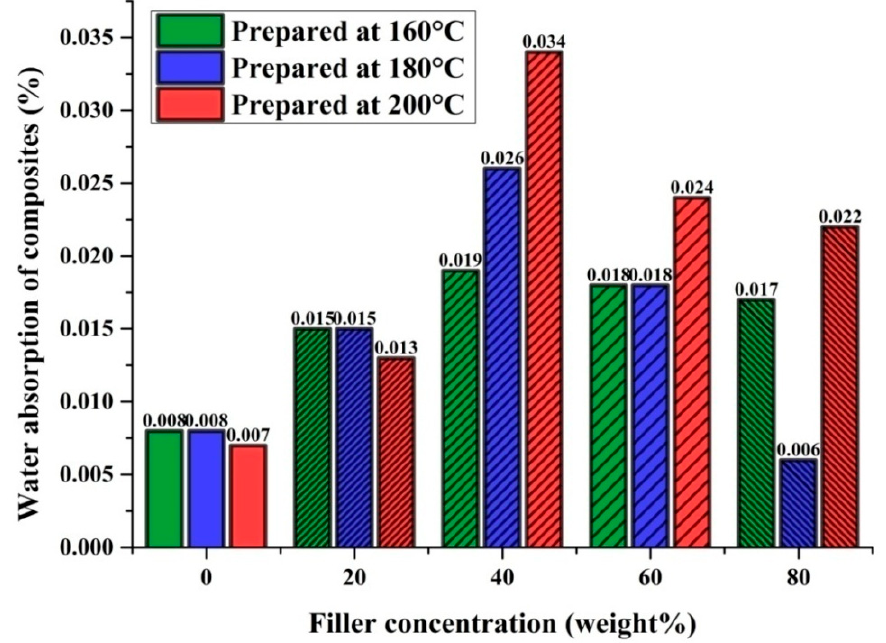
Figure 6. Water absorption of MP-PP composites/PP.